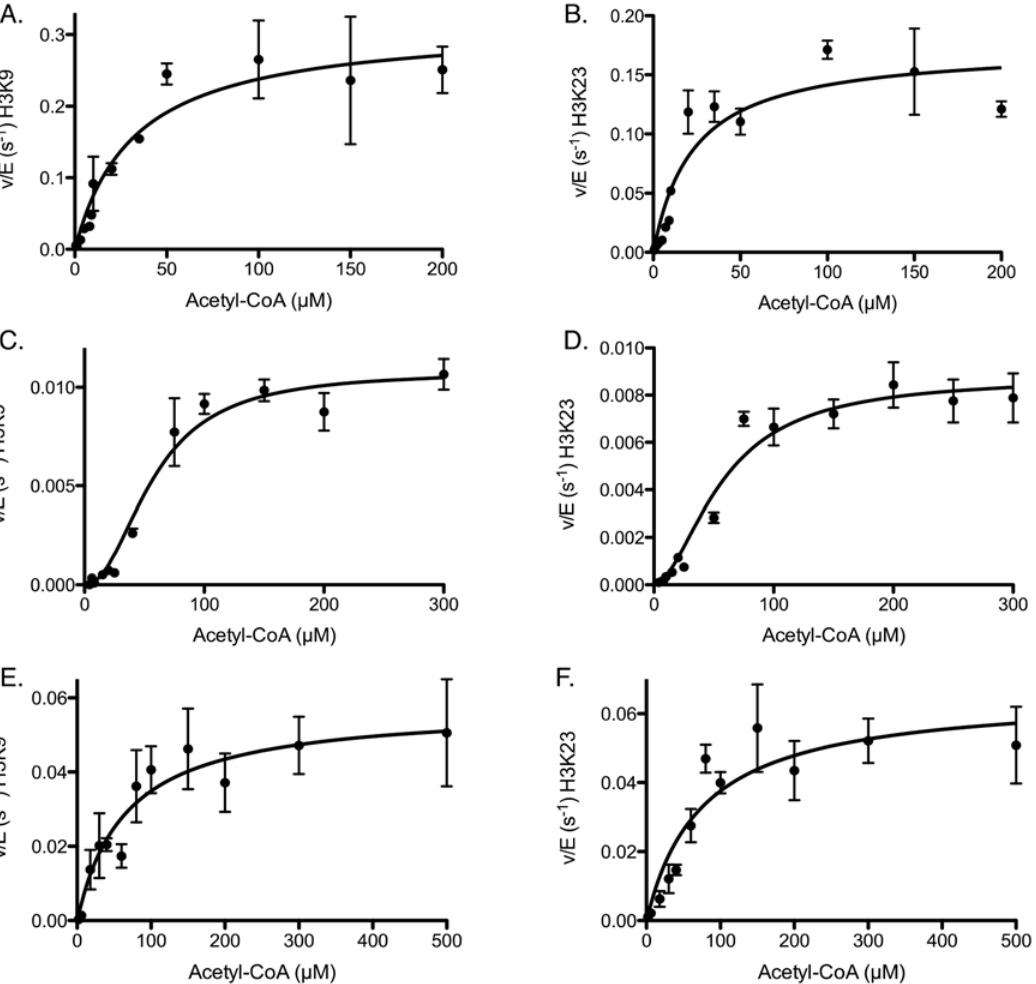
Fig 5. Determination of steady-state parameters for individual lysines of H3 and H3/H4 acetylation catalyzed by Rtt109-Vps75 when titrating acetyl- CoA in the presence of saturating histone. The detailed experimental conditions of the acetyl-CoA titration are described in the section “ Steady-state kinetic assays for Rtt109-Vps75 ” . The error bar represents the standard error in v/E. Panels (A) and (B) show the Michaelis-Menten behaviors for H3K9 and H3K23, respectively. Panels (C) and (D) show the cooperativity for K9 and K23, respectively, for H3/H4. The Hill coefficient is approximately equal to 2, suggesting acetyl-CoA may have cooperative effects on the Rtt109-Vps75 (2:2) complex. Panels (E) and (F) show the Michaelis-Menten behaviors (no cooperativity) for K9 and K23, respectively, when titrating acetyl-CoA in the presence of saturating H3/H4-Asf1. The apparent kinetic parameters are summarized in Table 2.